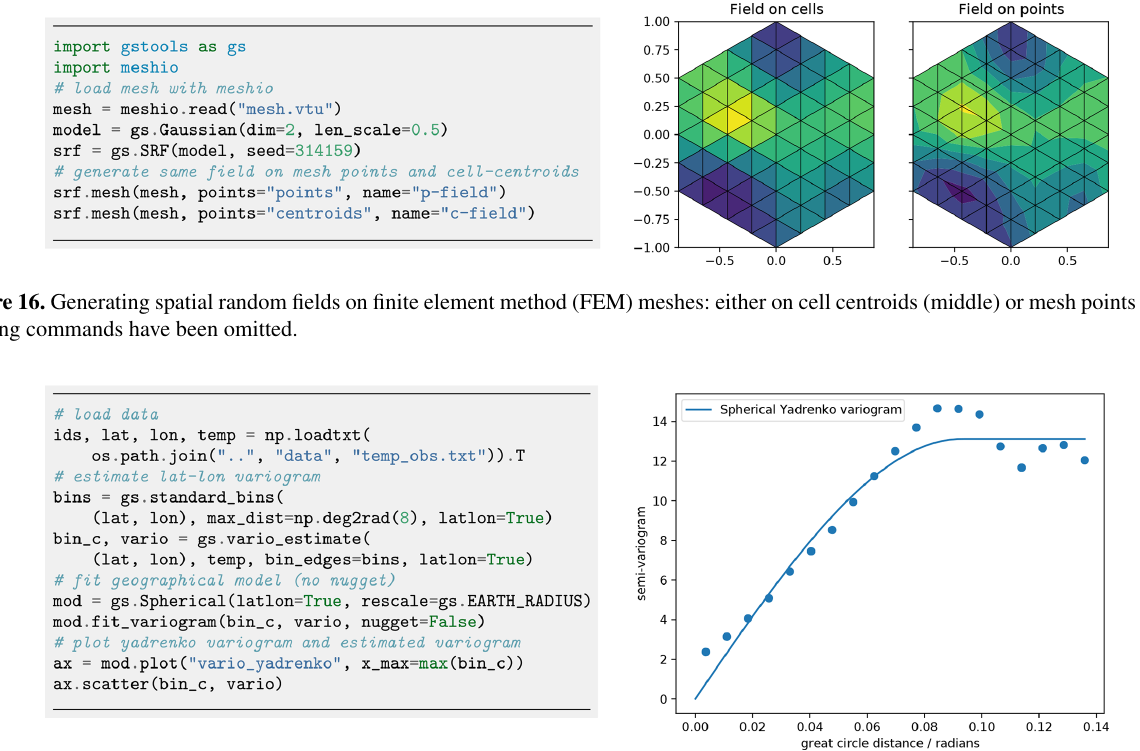
Figure 17. Estimating the temperature variogram with geographic coordinates using the spherical Yadrenko model. Estimated length scale is ca. 0 . 9 (radians) and sill is around 13.